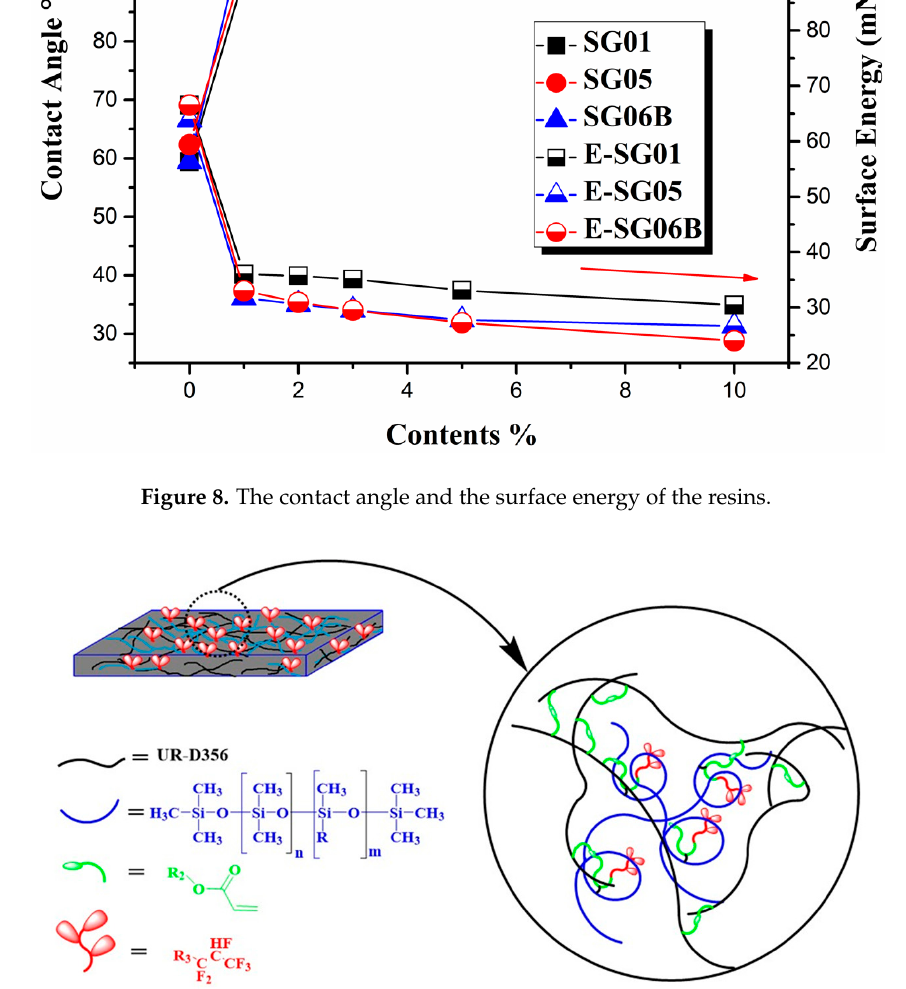
Figure 9. Schematic diagram of the micro-structure stage.